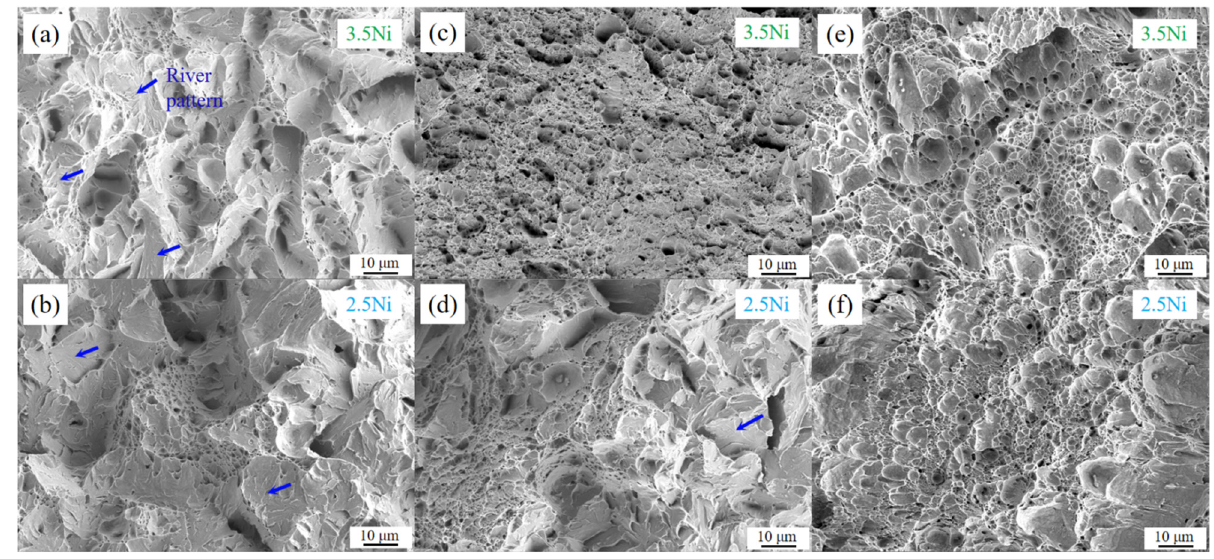
Figure 16. Representative impact fracture micrographs of two steels after different heat treatment processes. ( a , b ) Q860. ( c , d ) T500. ( e , f ) T620.